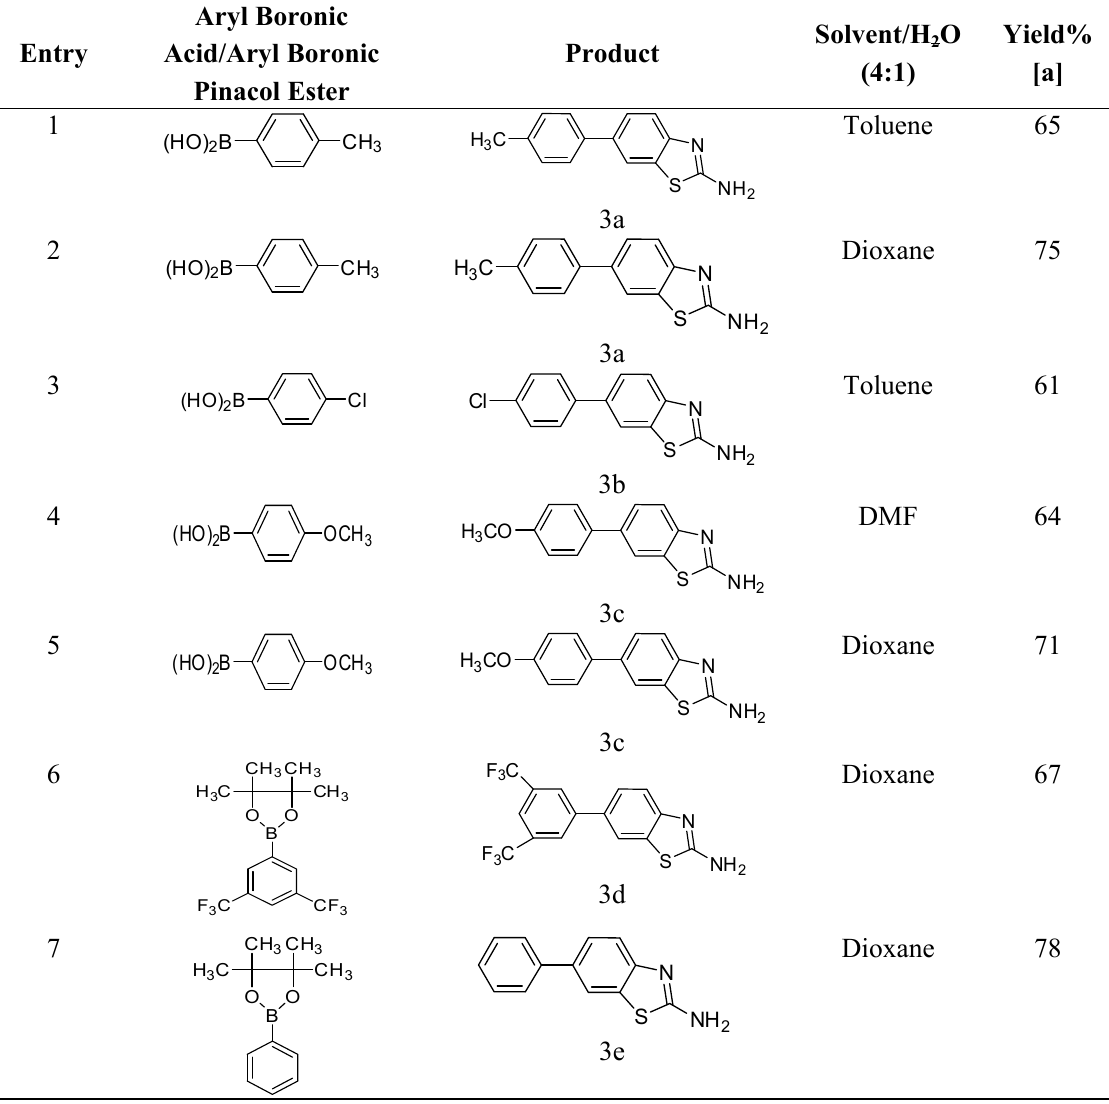
Table 1. Synthesis of